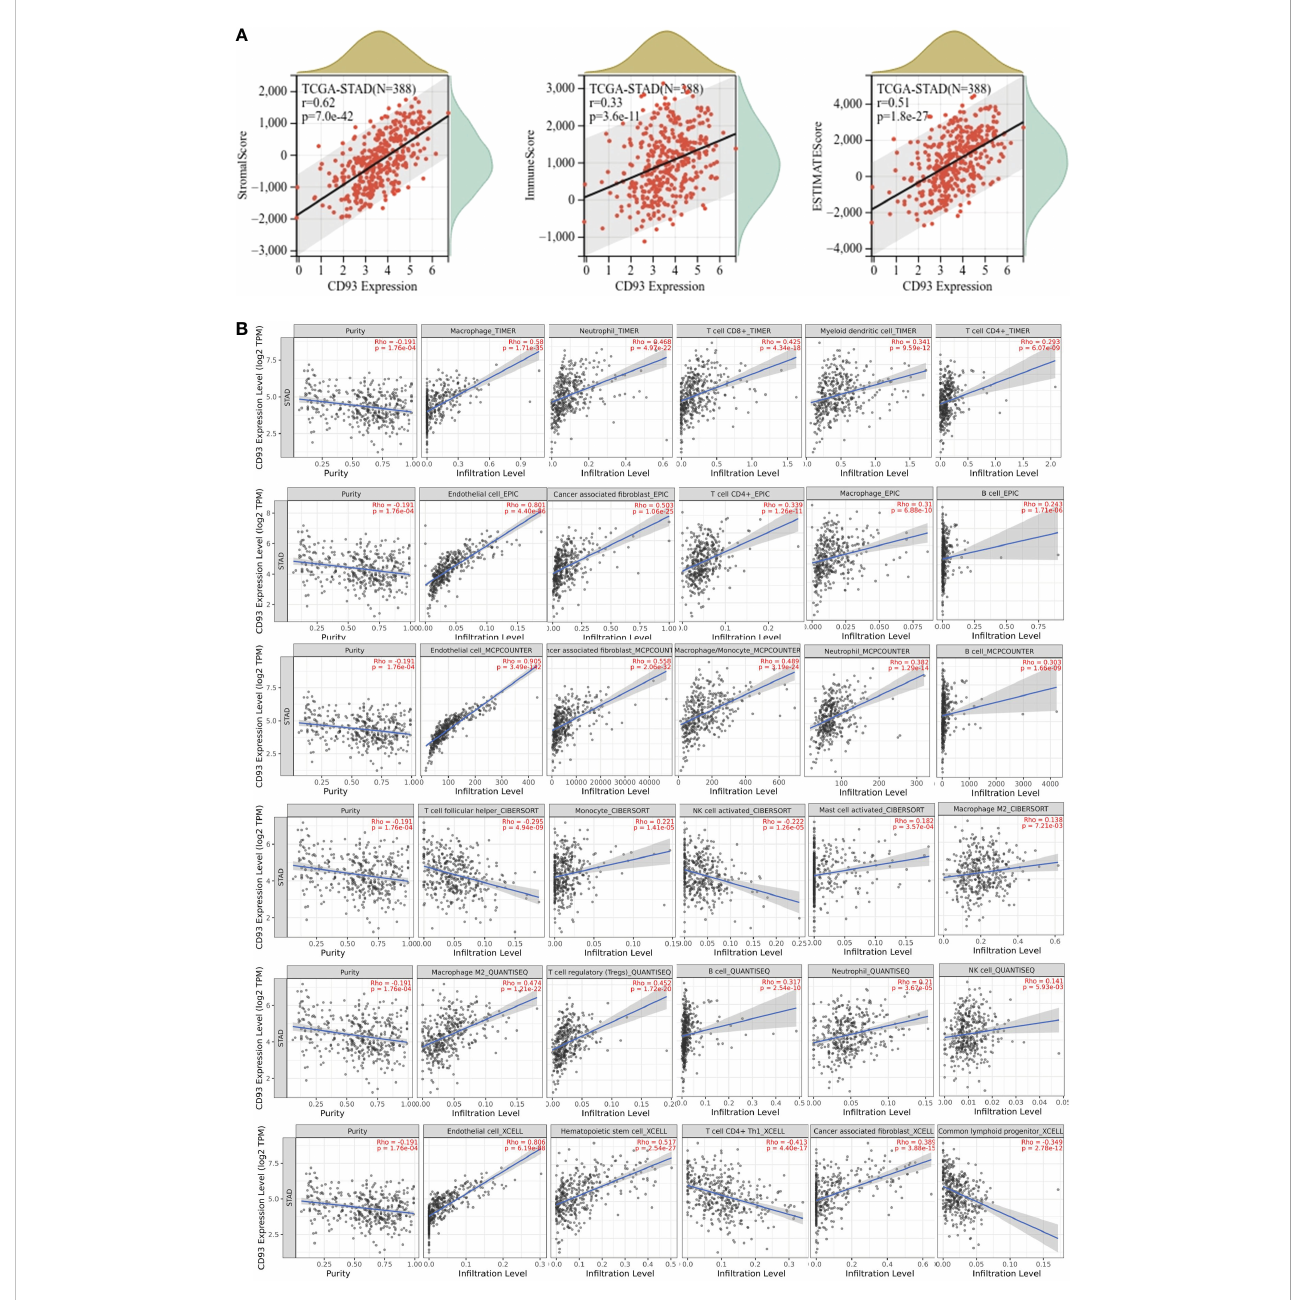
FIGURE 5 (A) Correlation of CD93 expression with stromal score (Spearman, r = 0.62, p = 8.3e-43), immune score (Spearman, r = 0.34, p = 3.2e-12), and ESTIMATE score (Spearman, r = 0.52, p = 2.4e-28) in stomach adenocarcinoma (STAD). (B) Correlations of CD93 expression and immune cell in fi ltration level in